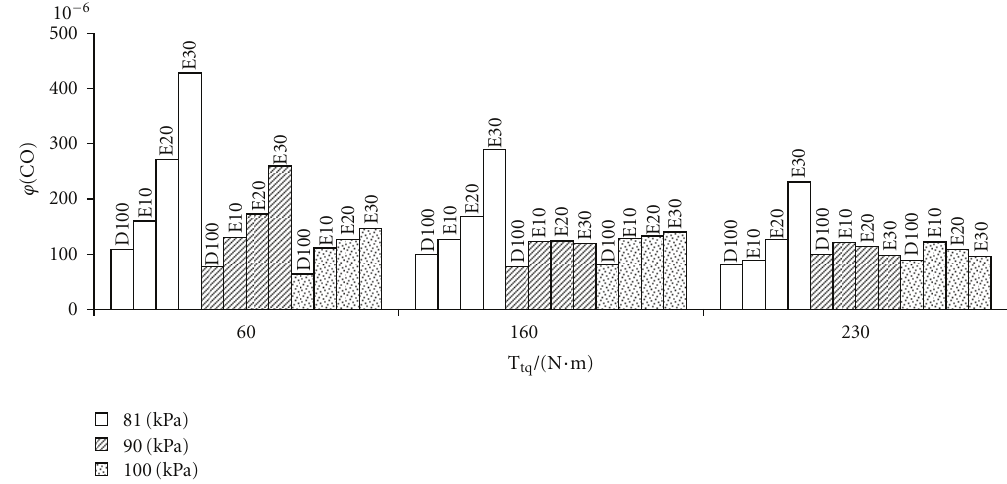
Figure 3: Comparison of HC emission of di ff erent atmospheric pressure and mix proportion at speed 2200 r/min.